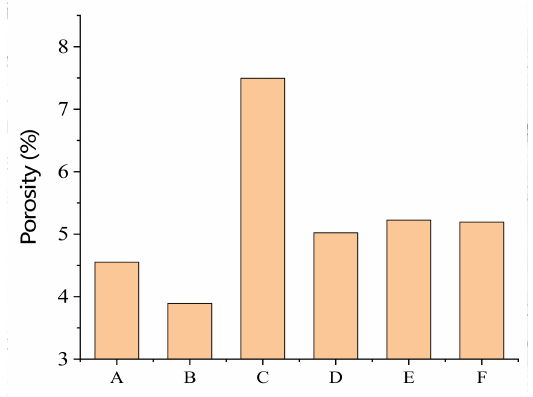
Figure 2. Porosity of calcined bauxite.